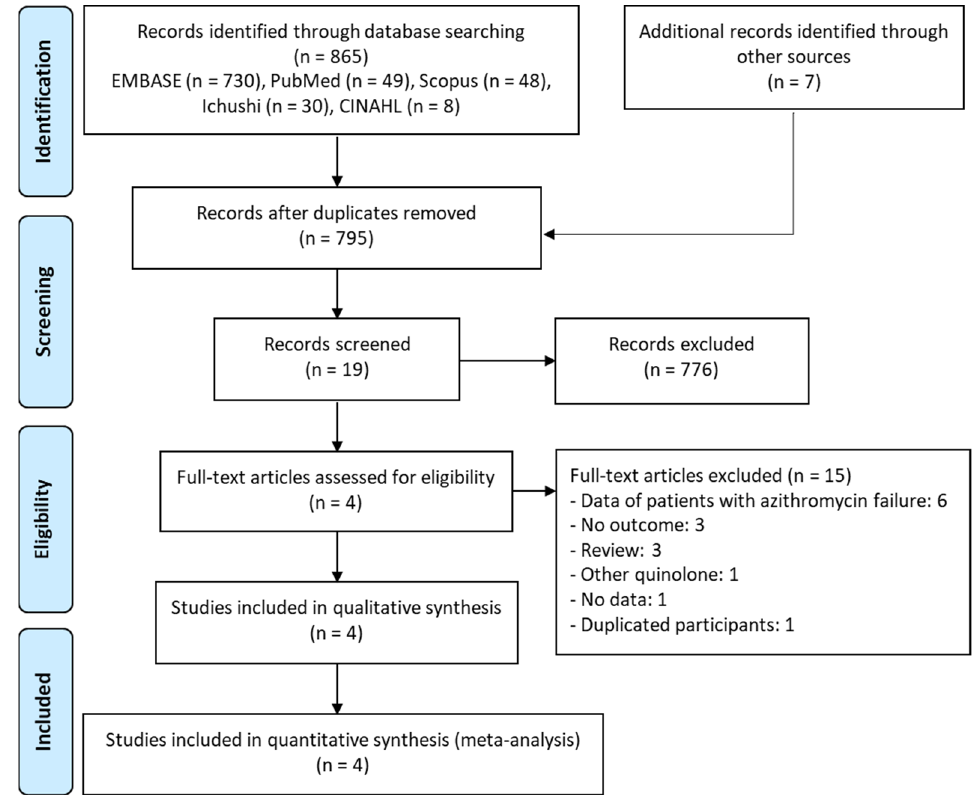
Figure 1. PRISMA flow diagram for the selection of eligible studies.